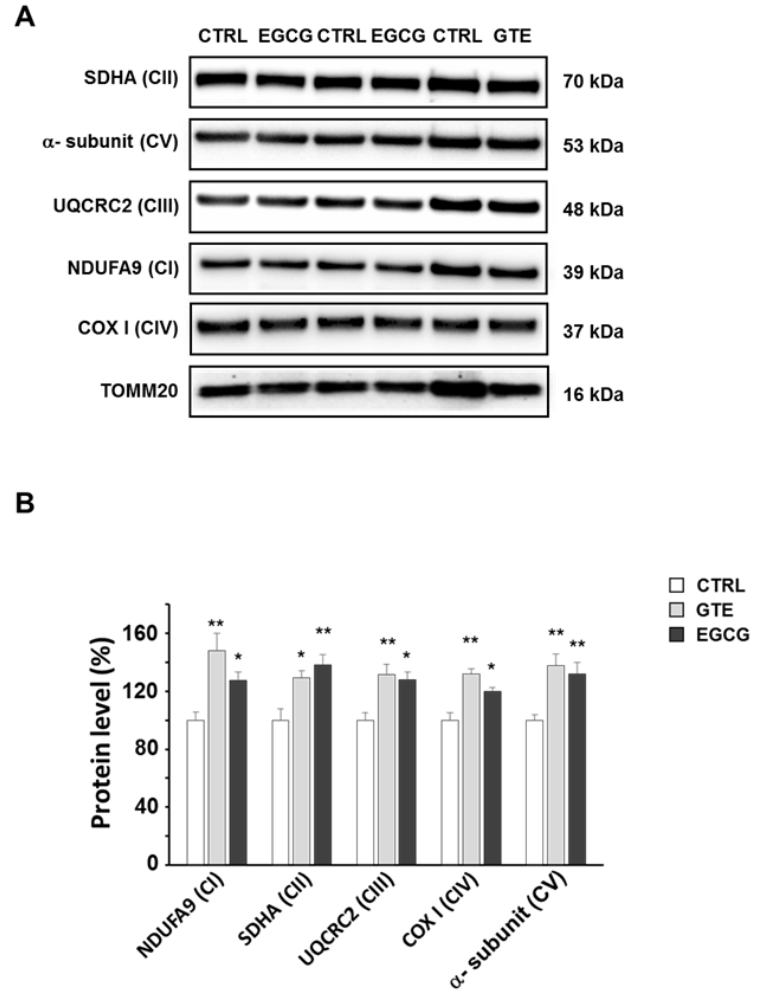
Figure 2. Oxidative phosphorylation (OXPHOS) complexes’ level in GTE and EGCG rat cardiomyocytes. ( A ) Typical electrophoretic separation and immunodetection of OXPHOS complexes in cell lysates of CTRL ( n = 5), GTE- ( n = 5), and EGCG-supplemented ( n = 5) rats. ( B ) The subunit level of each OXPHOS complex was determined by means of the ImageLab analysis software and normalized to the translocase of outer mitochondrial membrane 20 (TOMM20) protein level, taken as an index of loading control. Histograms show the mean ± SEM; * p < 0.05 and ** p < 0.01 indicate the statistical significance of data compared to